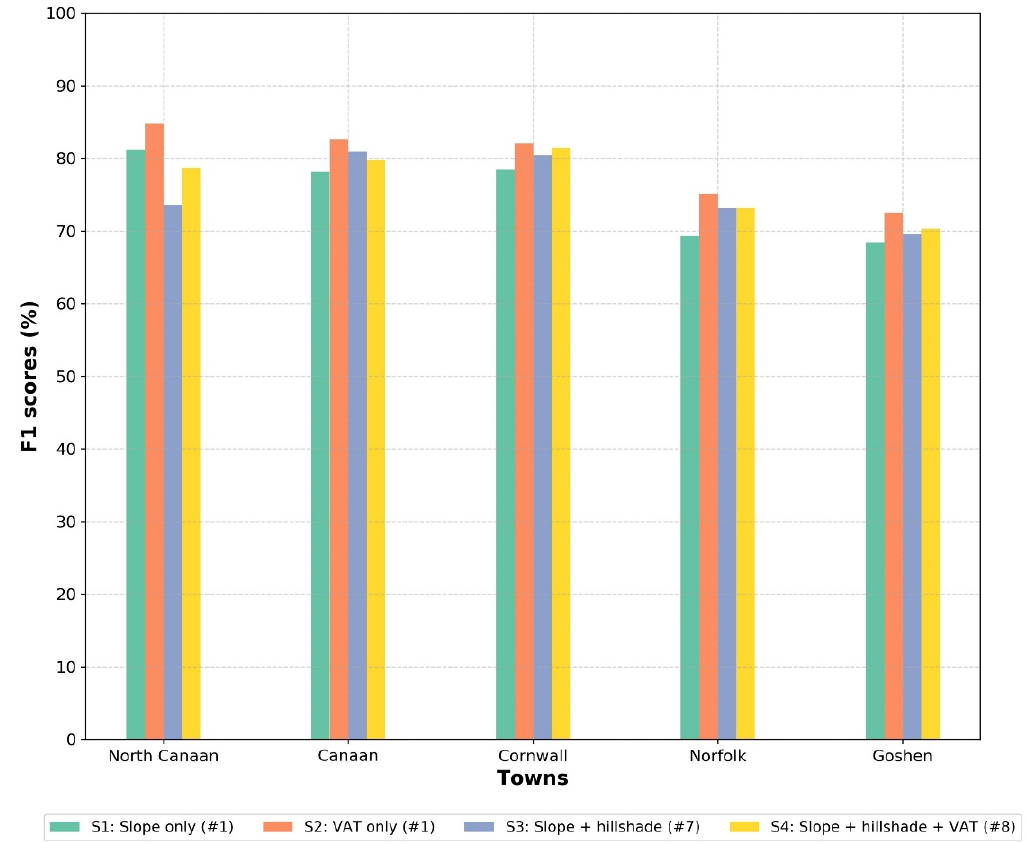
Figure 8. F1 score results for five towns (North Canaan, Canaan, Cornwall, Norfolk, and Goshen) in northwestern Connecticut. For Cornwall, accuracy was calculated without a training region. # refers to the number of rasters for input image.